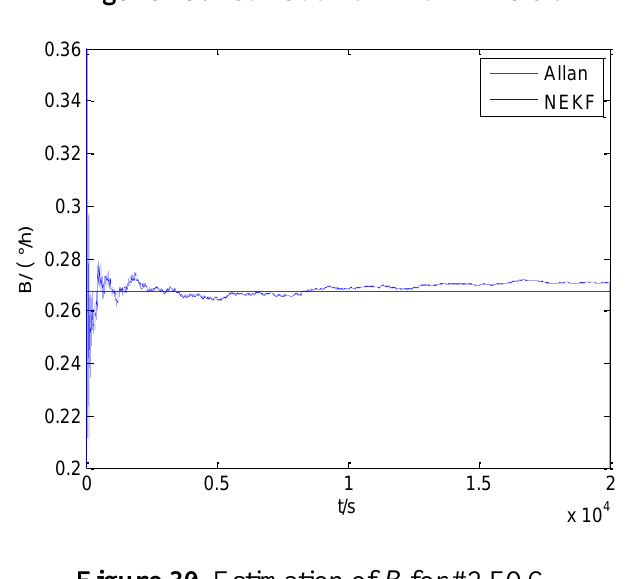
Figure 29. Estimation of N for #2 FOG.